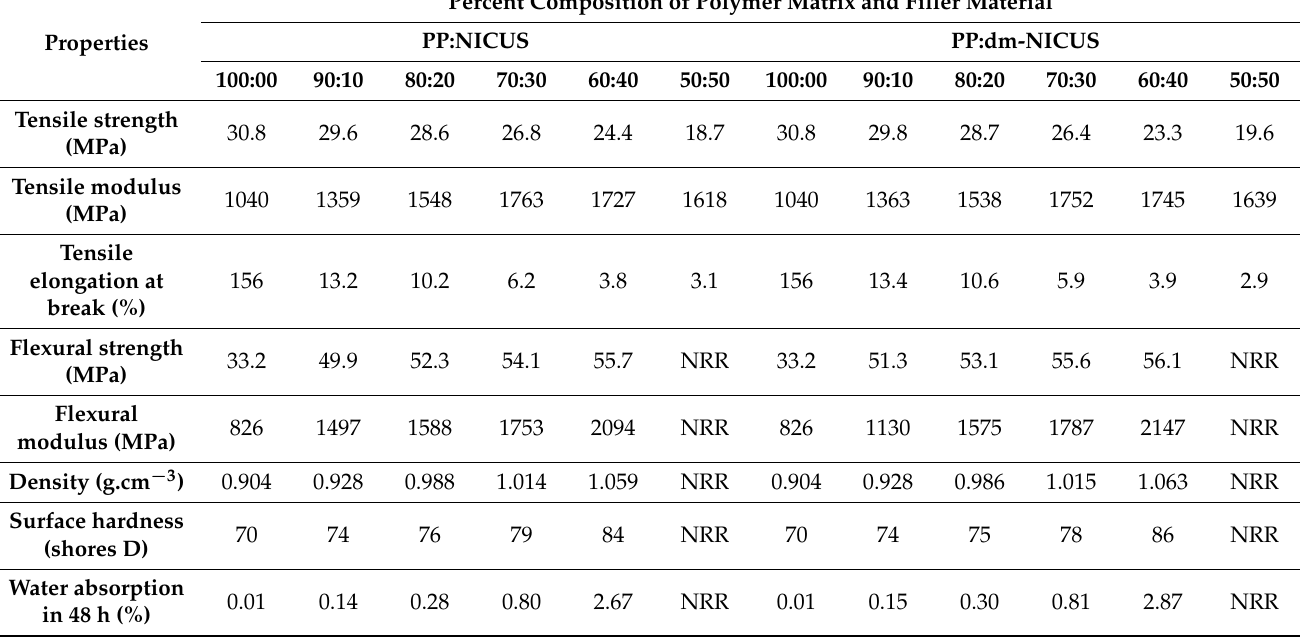
Table 8. Physicomechanical properties of thermoplastic polypropylene